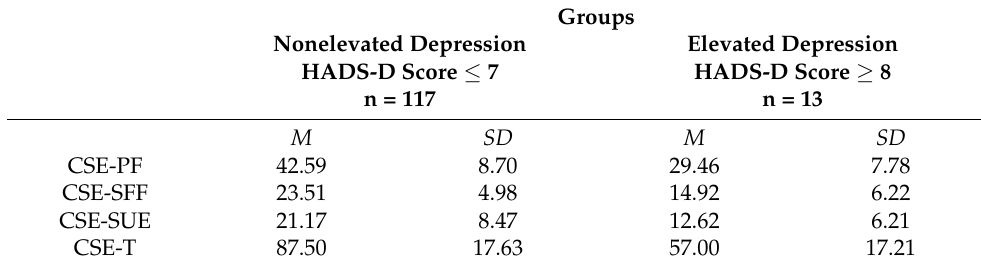
Table 4. Mean scores on the CSE according to depression level. Groups Nonelevated